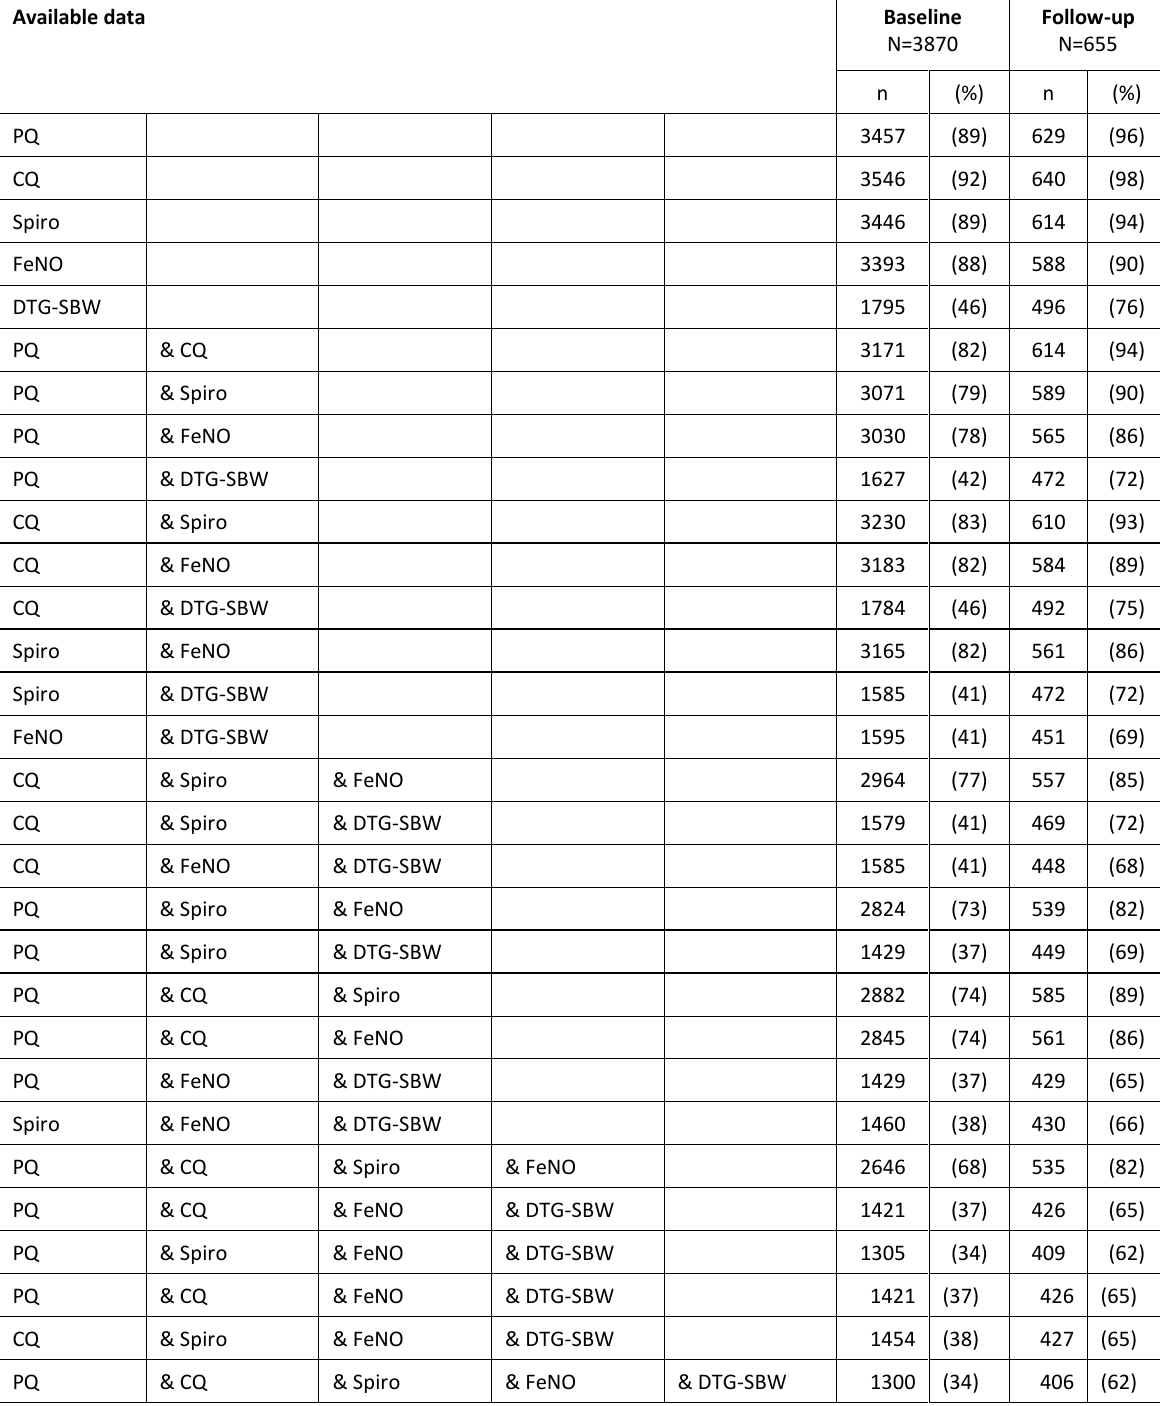
Table S2: Number of participants in the LuftiBus in the school (LUIS) study with available information on parental questionnaires (PQ), children’s questionnaires (CQ), spirometry (Spiro), and fractional exhaled nitric oxide (FeNO) at baseline and at the one-year